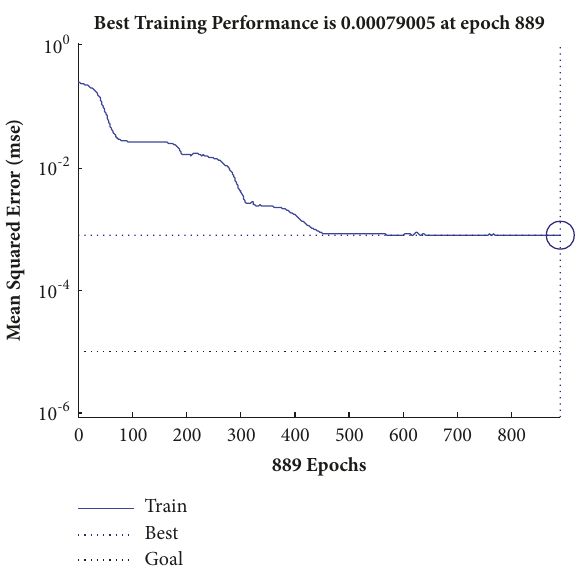
Figure 15: Error curve of the neural network training